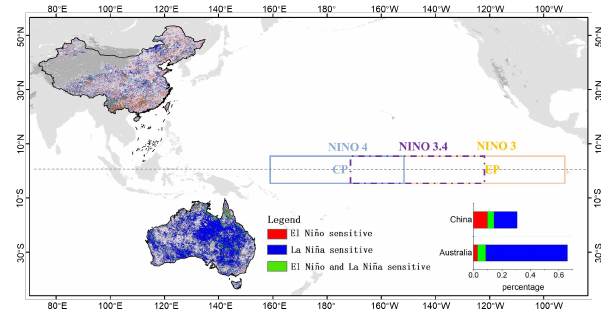
Figure 1 . The distribution of ENSO-sensitive vegetation areas.